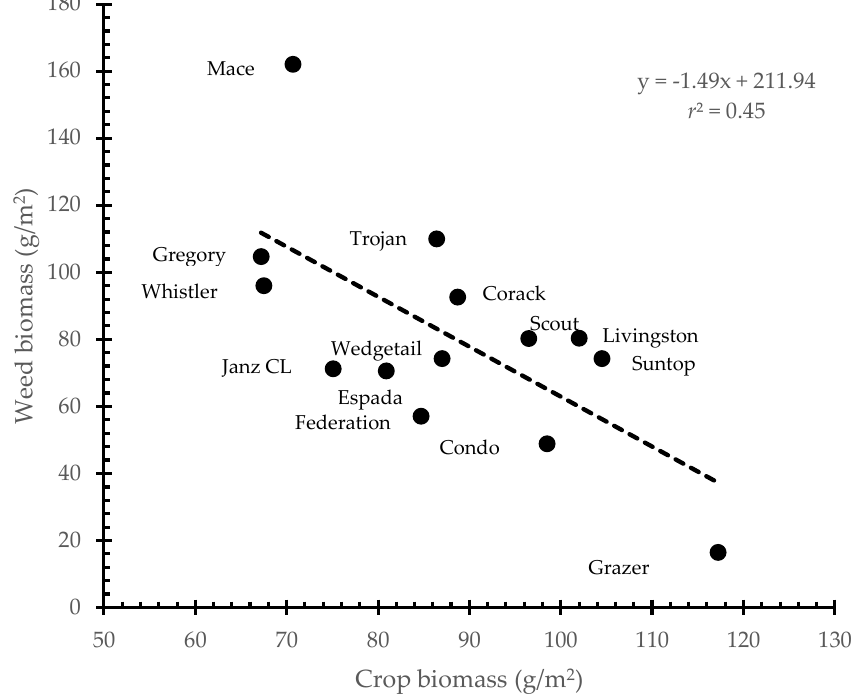
Figure 1. The relationship between mean wheat cultivar early biomass and weed biomass at crop maturity before flowering at Condobolin in 2015 and 2016. Each data value represents the average of the two-year mean of six replicates for each year.